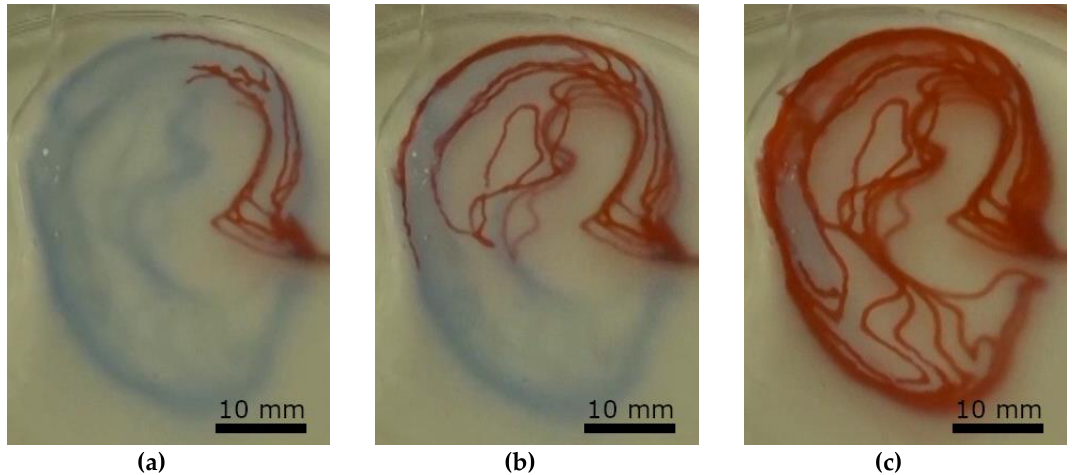
Figure 4. Perfusion test of the earlobe-shaped channel (Figure 3c) system at three different stages by manual injection of red ink (Pelikan 4001). ( a ) after initial injection, ( b ) half full channel system, ( c ) full channel system.